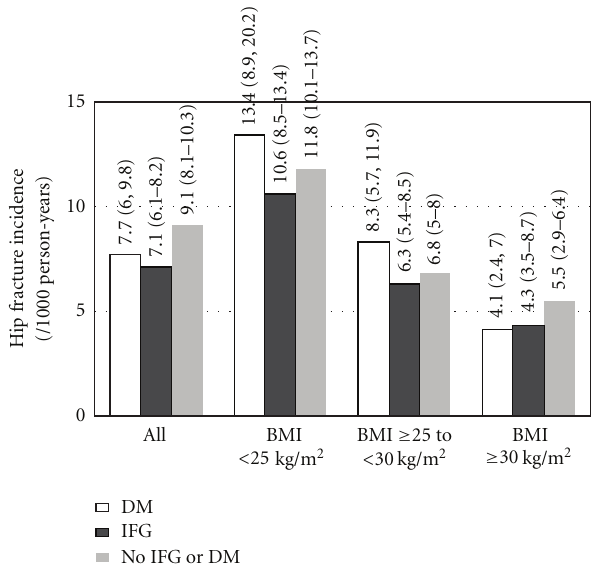
Table 3: Final model for association of impaired fasting glucose and Diabetes Mellitus with incident hip fracture.